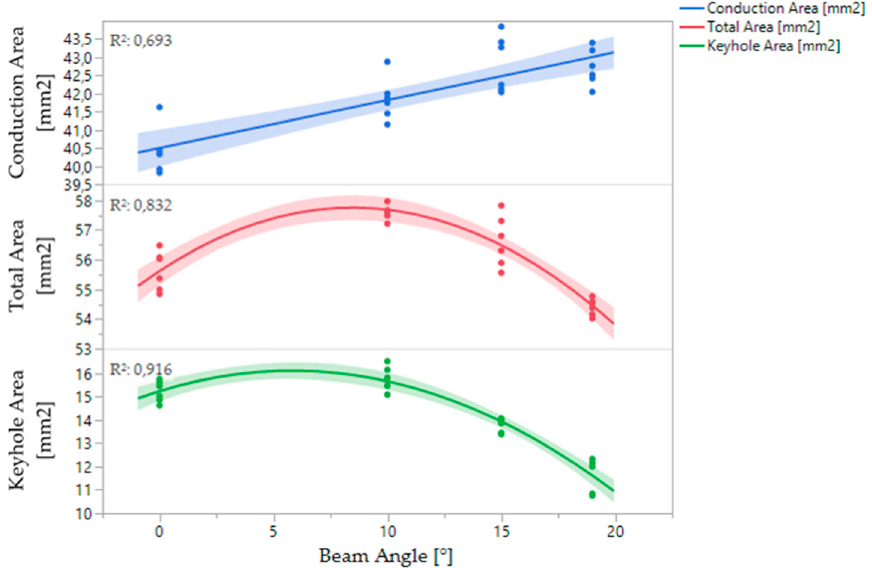
Figure 7. Relationship between the laser beam incident angle (degrees) and the total, conduction, and keyhole areas of the weld bead (mm 2 ), as described in Figure 6b. Image produced in JMP ® .